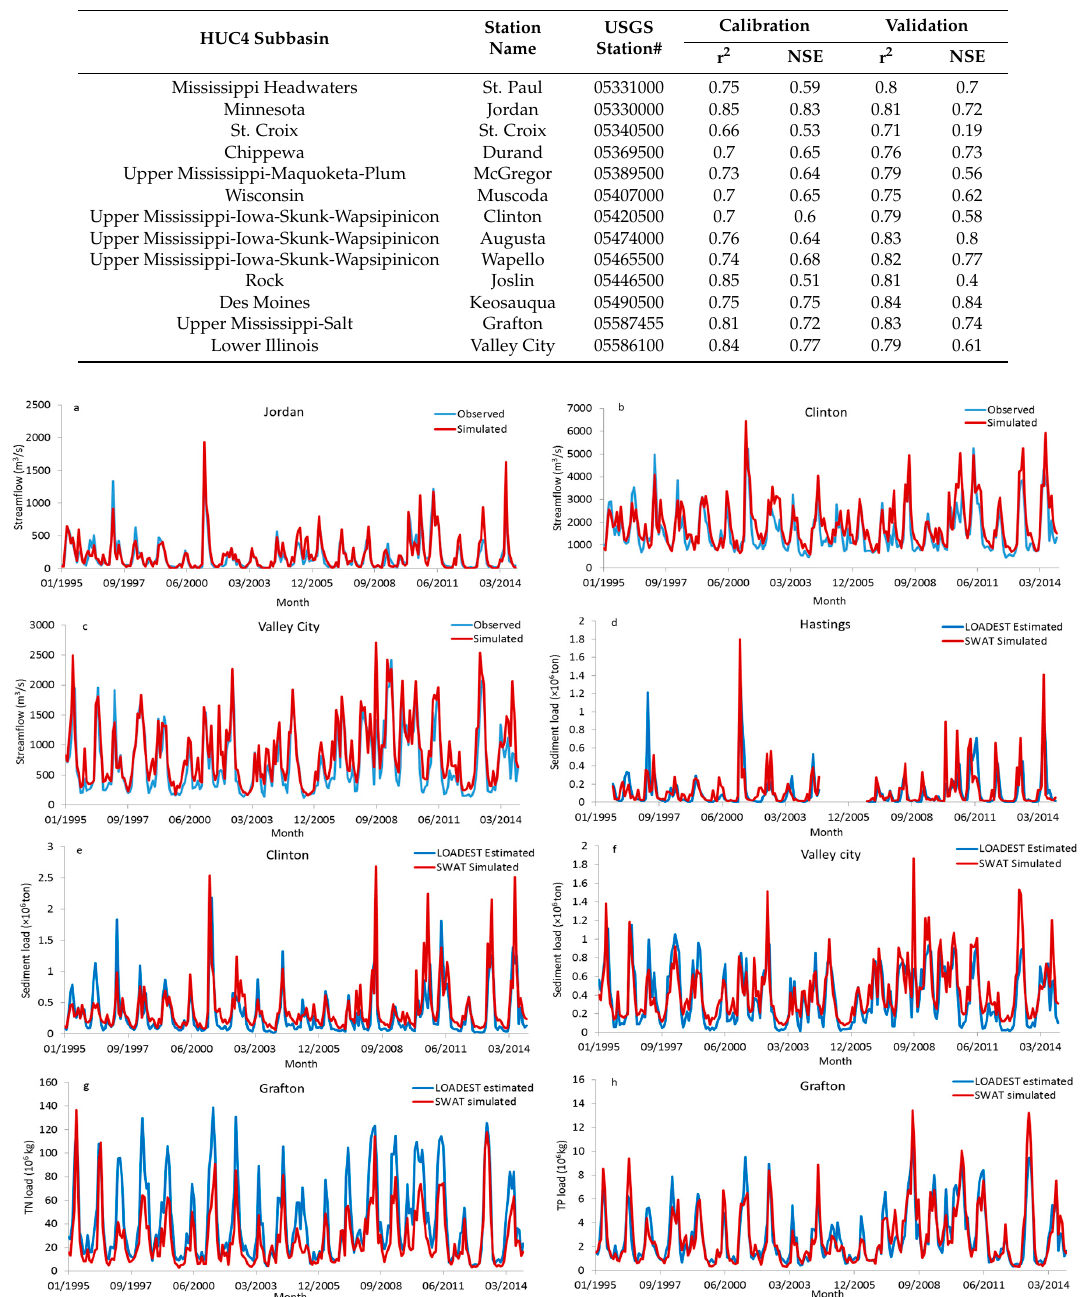
Figure 2. Monthly simulated versus observed streamflow, sediment, total nitrogen ( TN ), and total phosphorus ( TP ) loads for some stations in the UMRB.